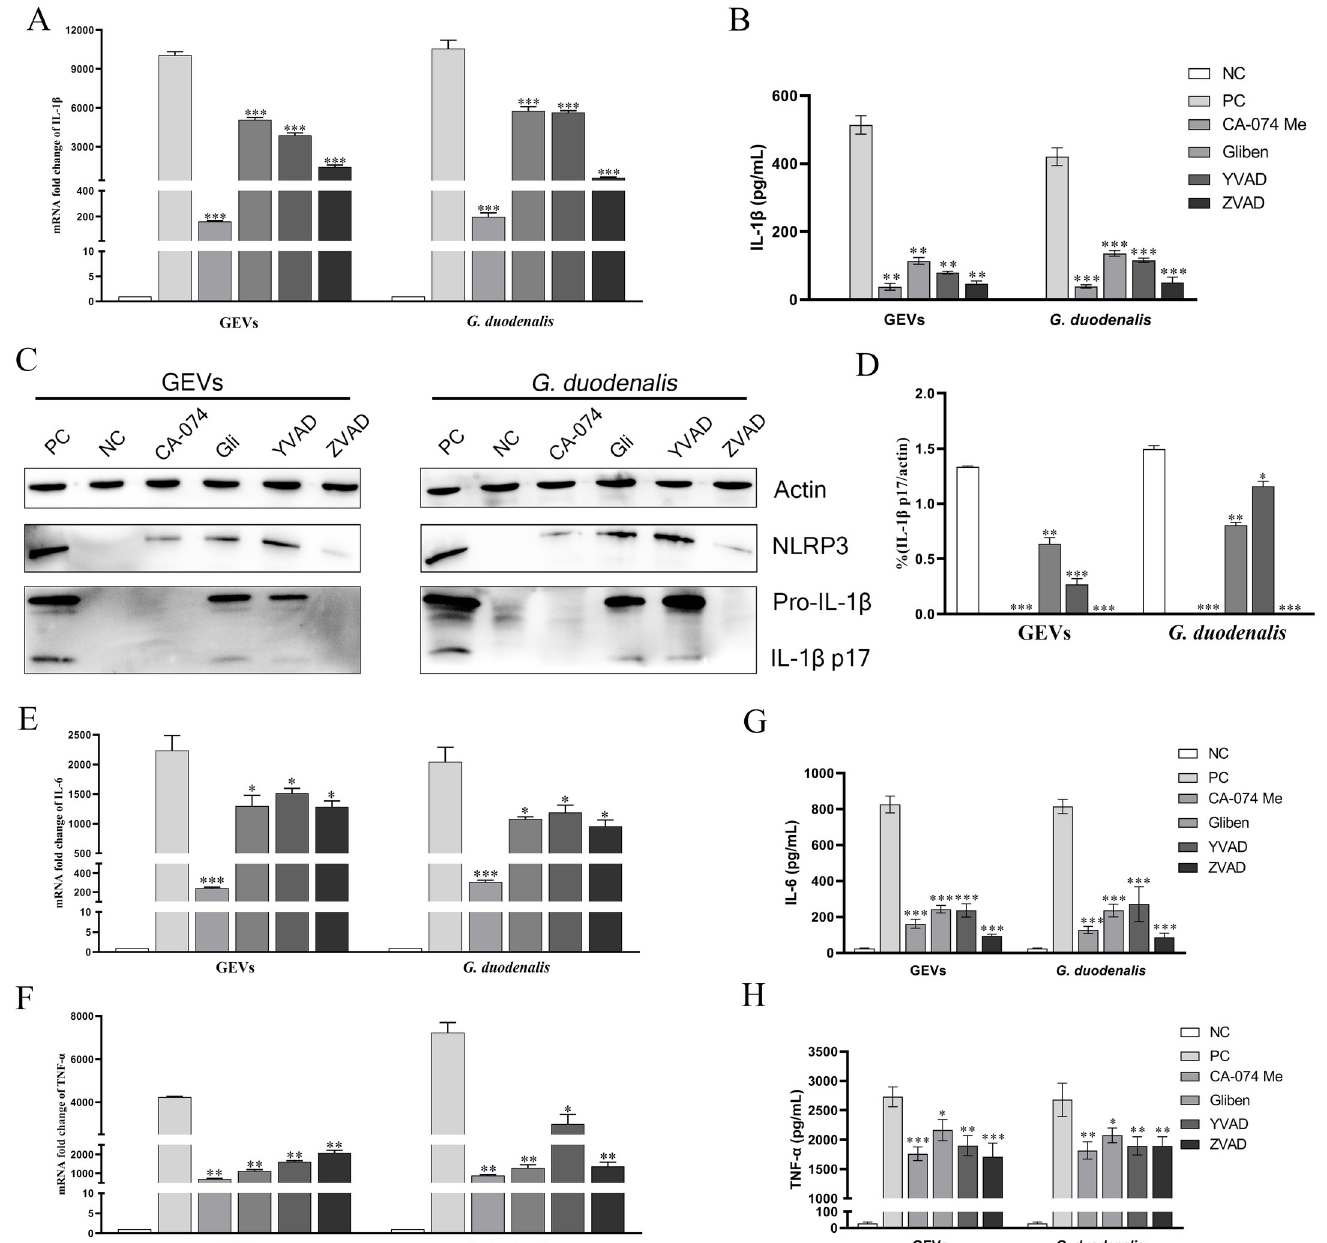
Fig 7. Roles of NLRP3 inflammasome in IL-1 β release and inflammatory response. Murine peritoneal macrophages were pre-treated with either 50 μ M Glibenclimide, 25 μ M CA-074 methyl ester, 100 μ M Ac-YVAD-CHO, or 10 μ M zVAD-fmk for 1 h and then inoculated with 25 μ g/mL GEVs or 1.5 × 10 6 parasites/ mL G . duodenalis for 12 h or 24 h. The mRNA level of pro-Il1 β in cells were measured (A). The protein expression levels of IL-1 β p17 in the SN were detected using ELISA (B) and western blot (C). Ratio percentage of active IL-1 β p17 and housekeeping actin was calculated (D). The mRNA levels of Tnf and Il6 were measured using qPCR (E-F). Secretion of TNF- α and IL-6 were measured using ELISA (G-H). The data are expressed as the mean ± SEM from three separate experiments, � p < 0.05, �� p < 0.01 or ��� p < 0.001 for different treated time groups or different treated amount